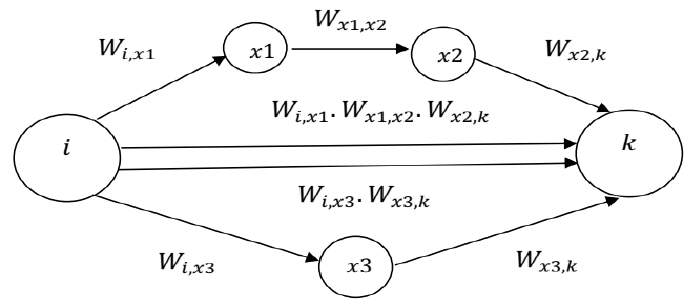
Figure 1. Example of viewpoint calculation for non-neighbors 𝑖 and 𝑘 .